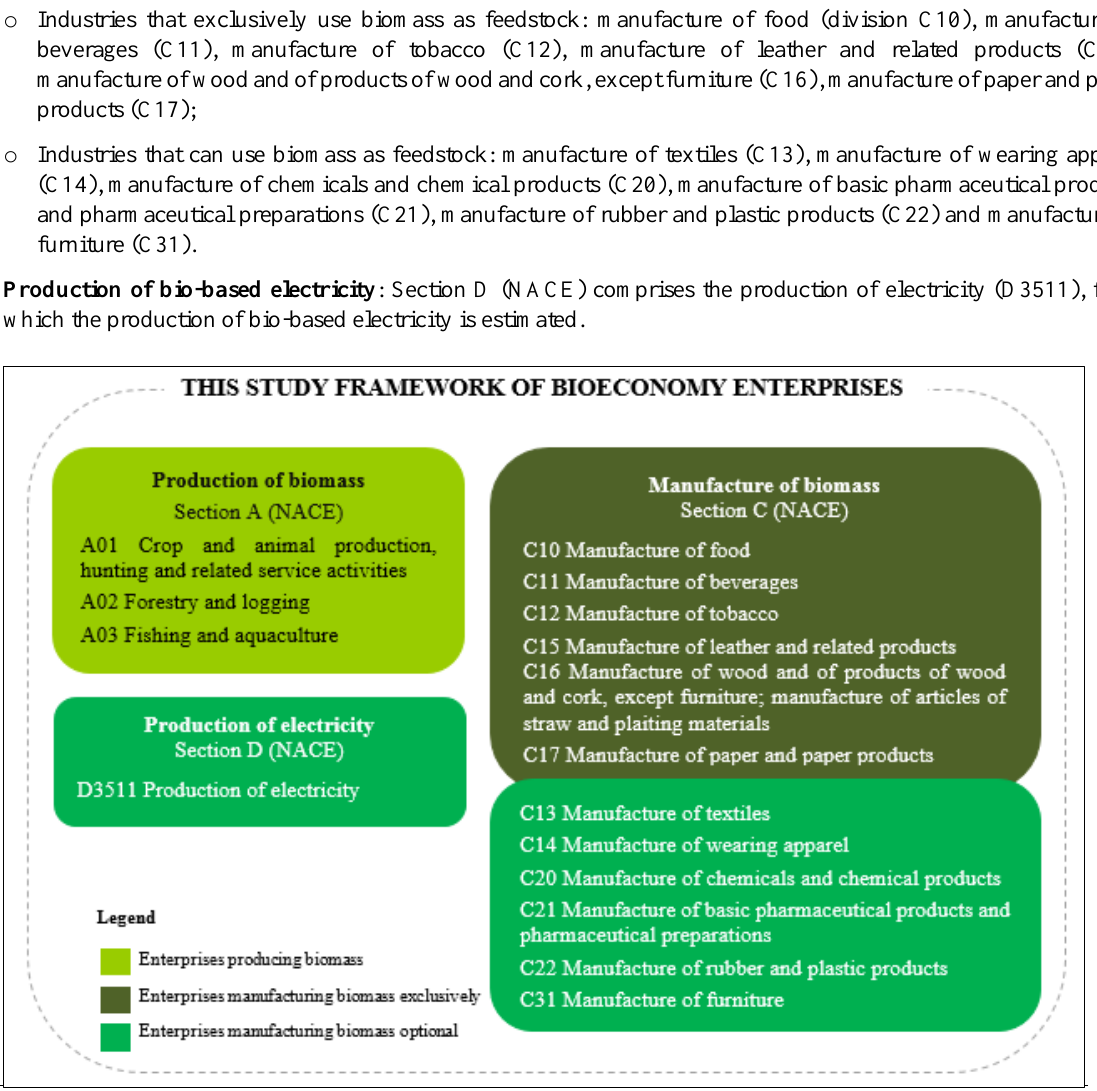
Figure 1. The framework of bioeconomy enterprises (according to the NACE Rev. 2 classification) used in the